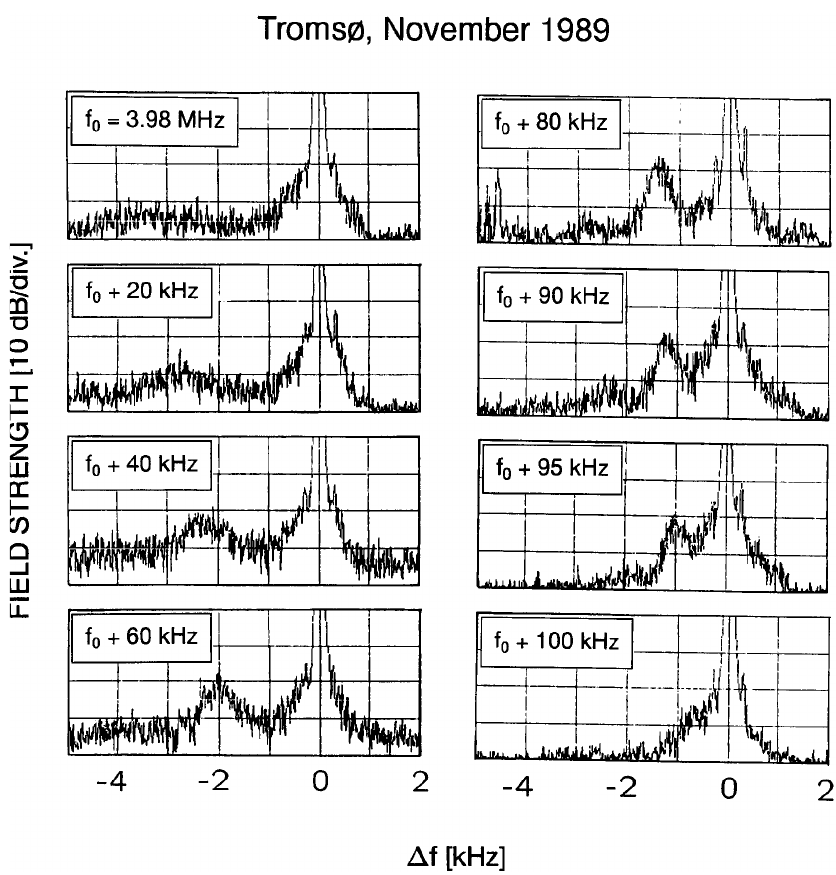
Fig. 1. The behaviour of the downshifted peak (DP) near the third gyroharmonic. Note that the frequency scale of the plots is limited to just to a few kHz in width. The plot was made using data obtained by the Tromsø HF facility in November 1989. Reproduced from Stubbe and Hagfors